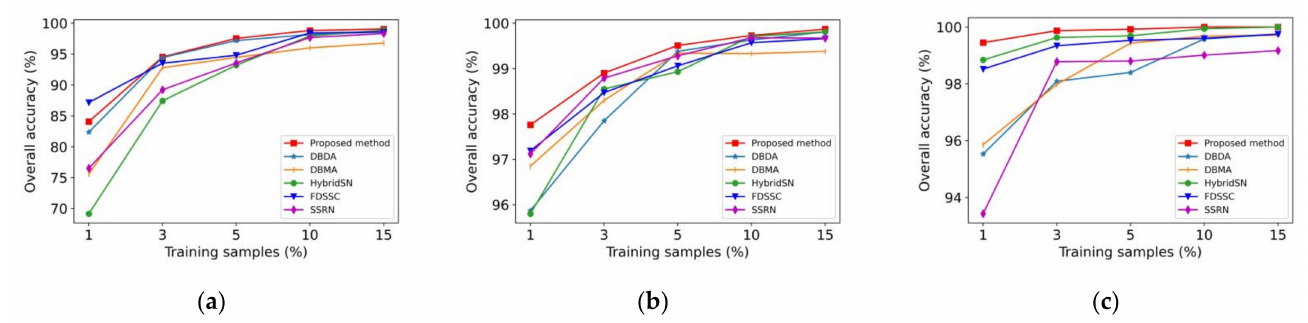
Figure 8. OA of six methods with different numbers of training samples on ( a ) IP; ( b ) PU; ( c ) SA.